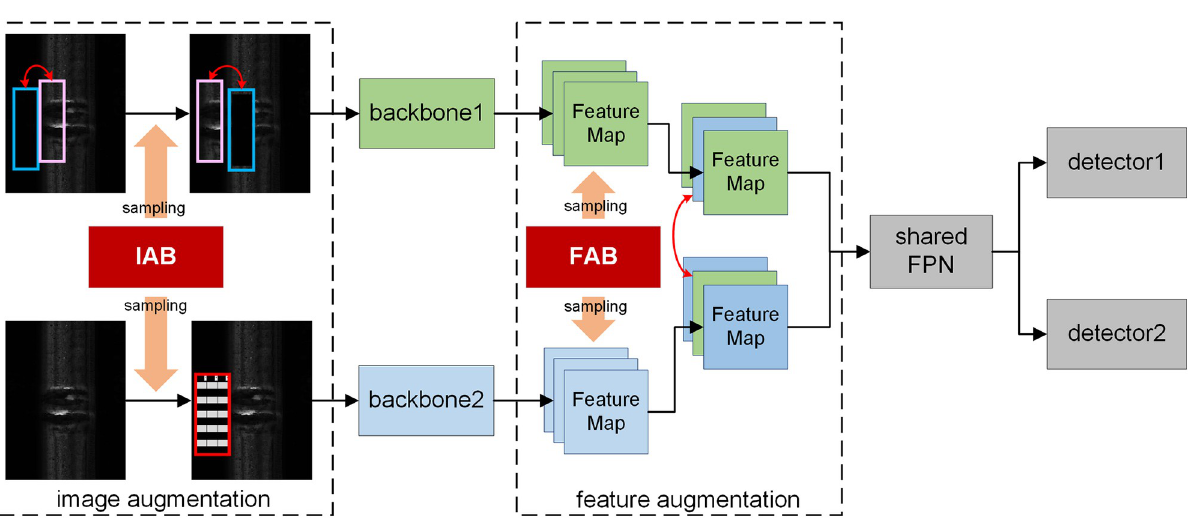
PLOS ONE | https://doi.org/10.1371/journal.pone.0268518 May 17,